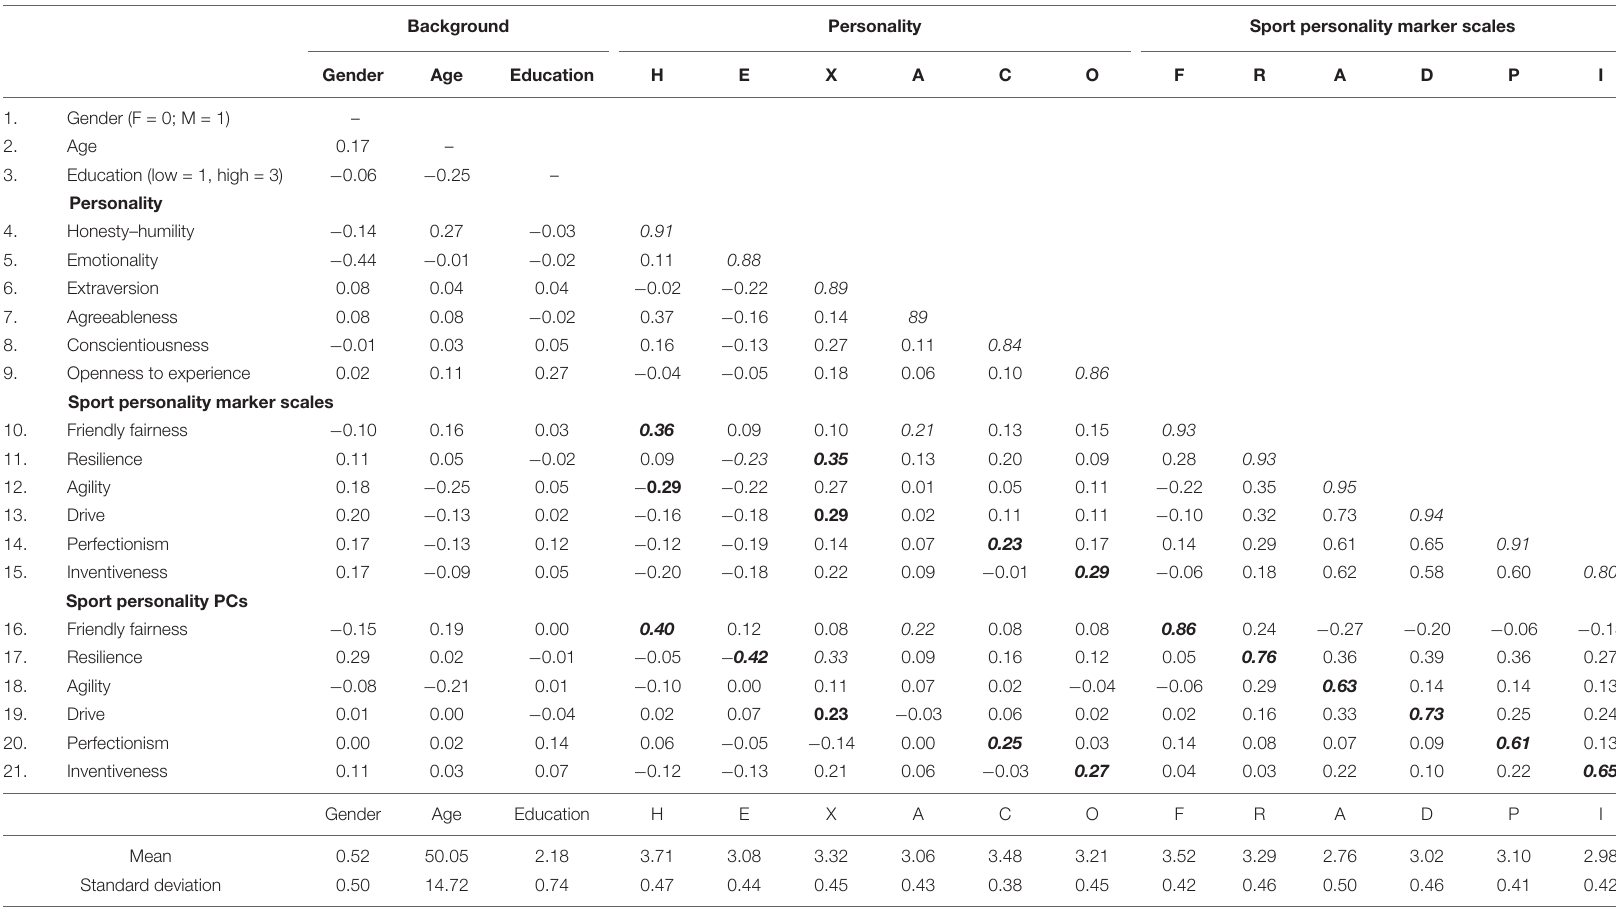
TABLE 3 | Descriptives (alpha reliabilities on diagonal) and correlations of sport personality marker scales with background variables, HEXACO personality, and sport personality